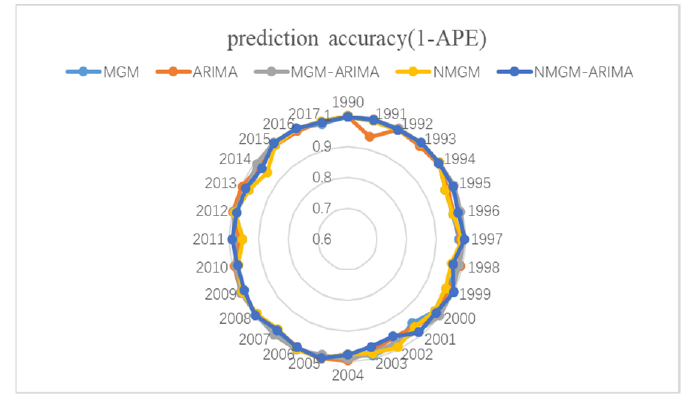
Figure 21. The mean absolute percent error of the five models. Figure 20. The predicted value of the five models and the actual power generation. Line chart, GWh).